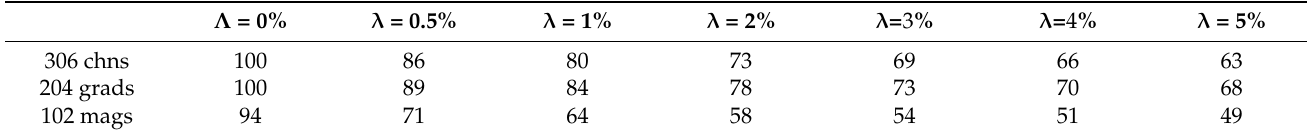
Table 2. Amplitude values (nAm) of the source montage channels with the highest SNR in Simula- tion 1. These values are averages of the 29 sources at the source montage locations. The simulated source amplitude was 100